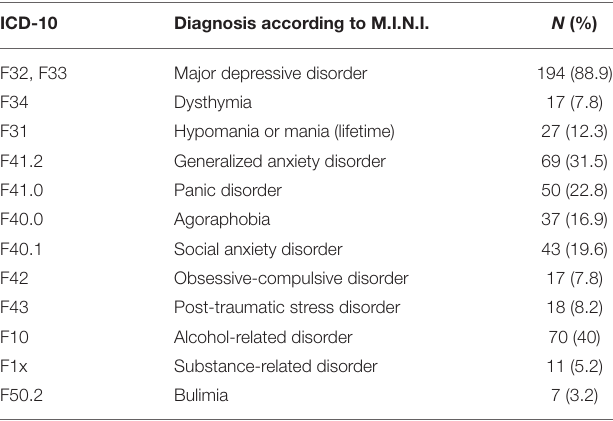
TABLE 1 | All psychiatric diagnoses of the Ostrobothnian Depression Study patients ( n = 219) at baseline according to the Mini-International Neuropsychiatric Interview